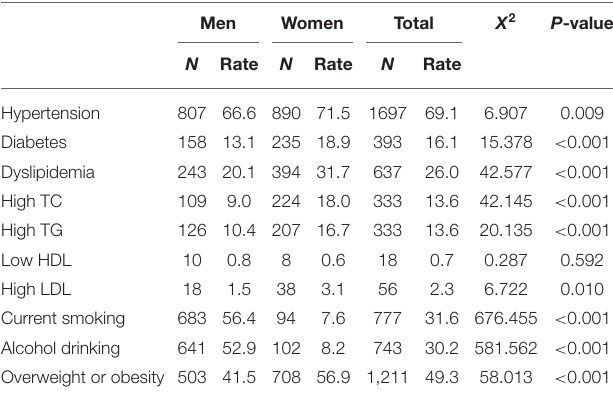
TABLE 4 | Prevalence of main risk factors among participants with carotid atherosclerosis by sex in rural Northeast China. Men Women